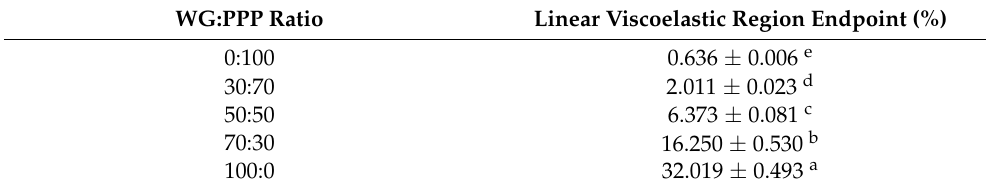
Figure 4. The changes in energy storage modulus G ′ ( a ), energy loss modulus G ″ ( b ), and tan δ ( c ) of di ff erent raw material–water mixtures under strain sweep. Table 2. Linear viscoelastic region endpoints for different ratios of raw